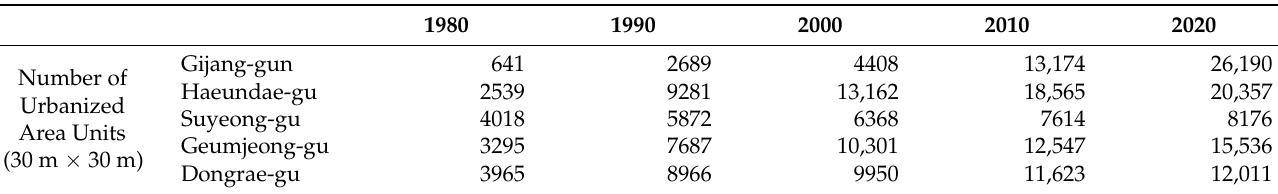
Table 3. Number of urbanized area units (30 m × 30 m) and Bachi’s